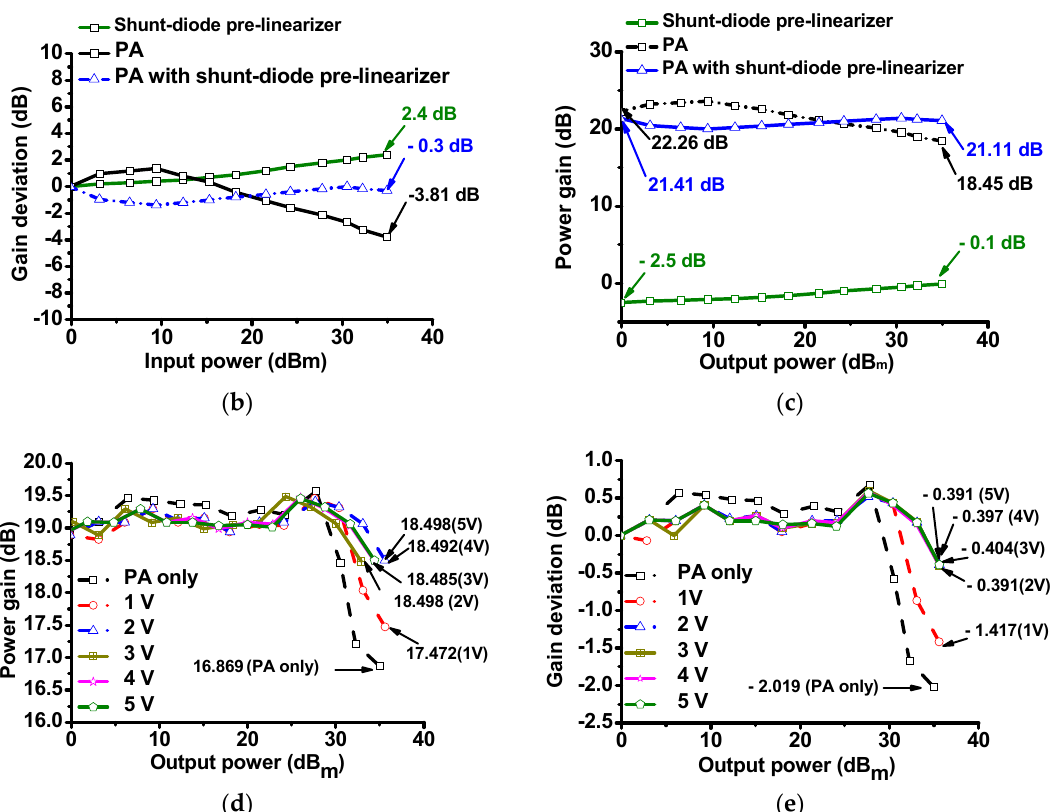
Figure 3. ( a ) The experimental setup of the PA with and without shunt-diode pre-linearizer; expected results of ( b ) gain deviation and ( c ) power gain graphs of the PA with and without shunt-diode pre-linearizer at 5 V DC voltage; ( d ) power gain deviation and ( e ) gain deviation graph of the PA with and without shunt-diode pre-linearizer.